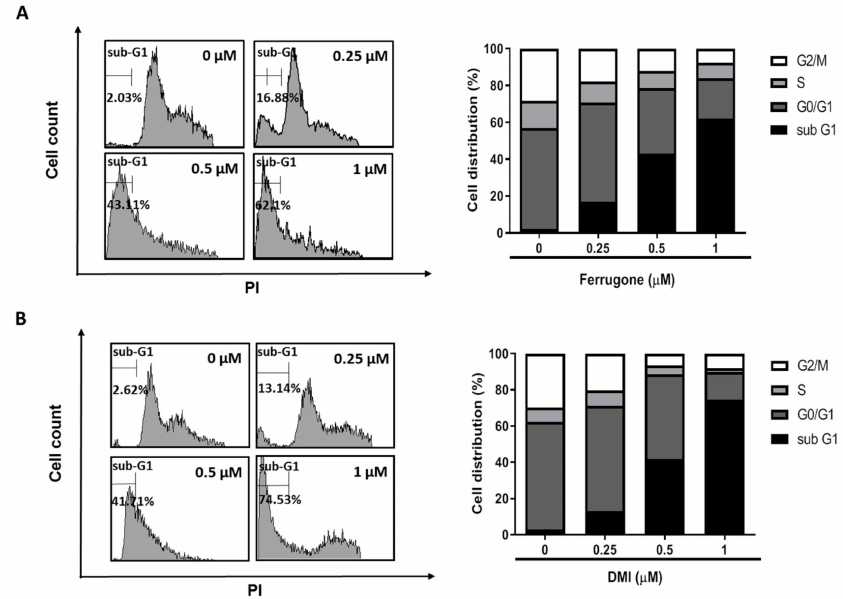
Figure 1. E ff ect of ferrugone and DMI on cell cycle distribution in human ovarian cancer cells. A2780 cells were treated with ferrugone ( A ) or DMI ( B ) (0.25, 0.5, and 1 µ M) for 48 h and then stained with propidium iodide (PI). The cell-cycle distribution profiles of the cells were determined by flow cytometry. The graph indicates the percentages of cells in the sub-G1, G0 / G1, S, and G2 / M phases of the cell cycle. The data are representative of three independent